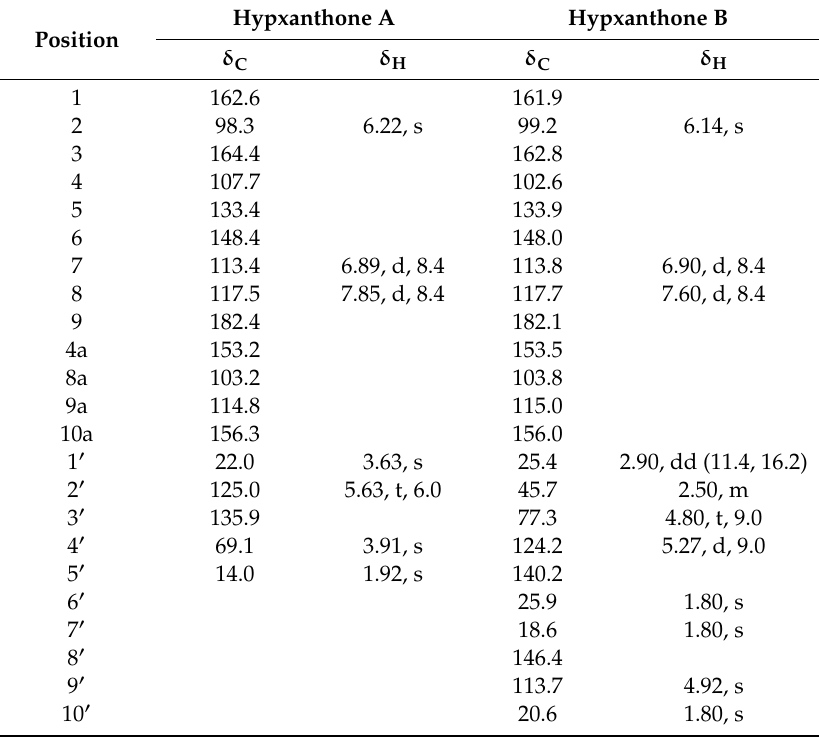
Table 1. 13 C- and 1 H-NMR spectroscopic data (151 / 600 MHz) for hypxanthone A and hypxanthone B in methanol- d 4 ( δ in ppm, J in